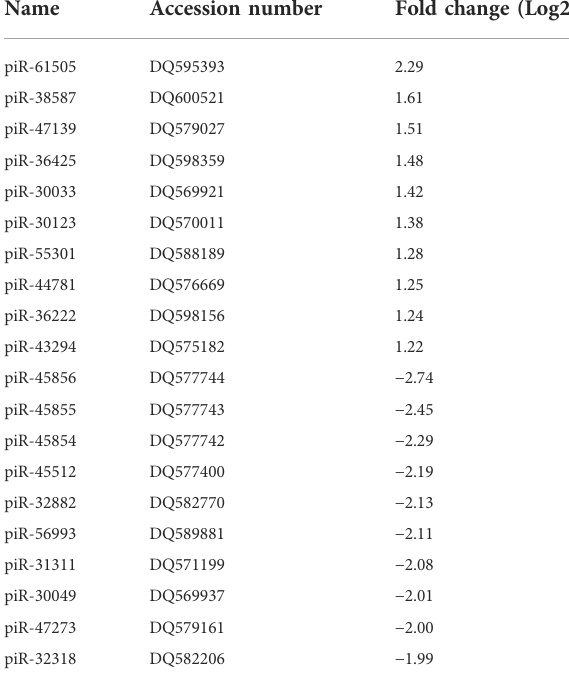
TABLE 1 Top 10 highly up- ( ≥ 2 fold) and down-regulated ( ≤ 2 fold) piRNAs by RSV 6 h p.i ( p ≤ 0.01). DQ is the accession number of piRNA in the NCBI